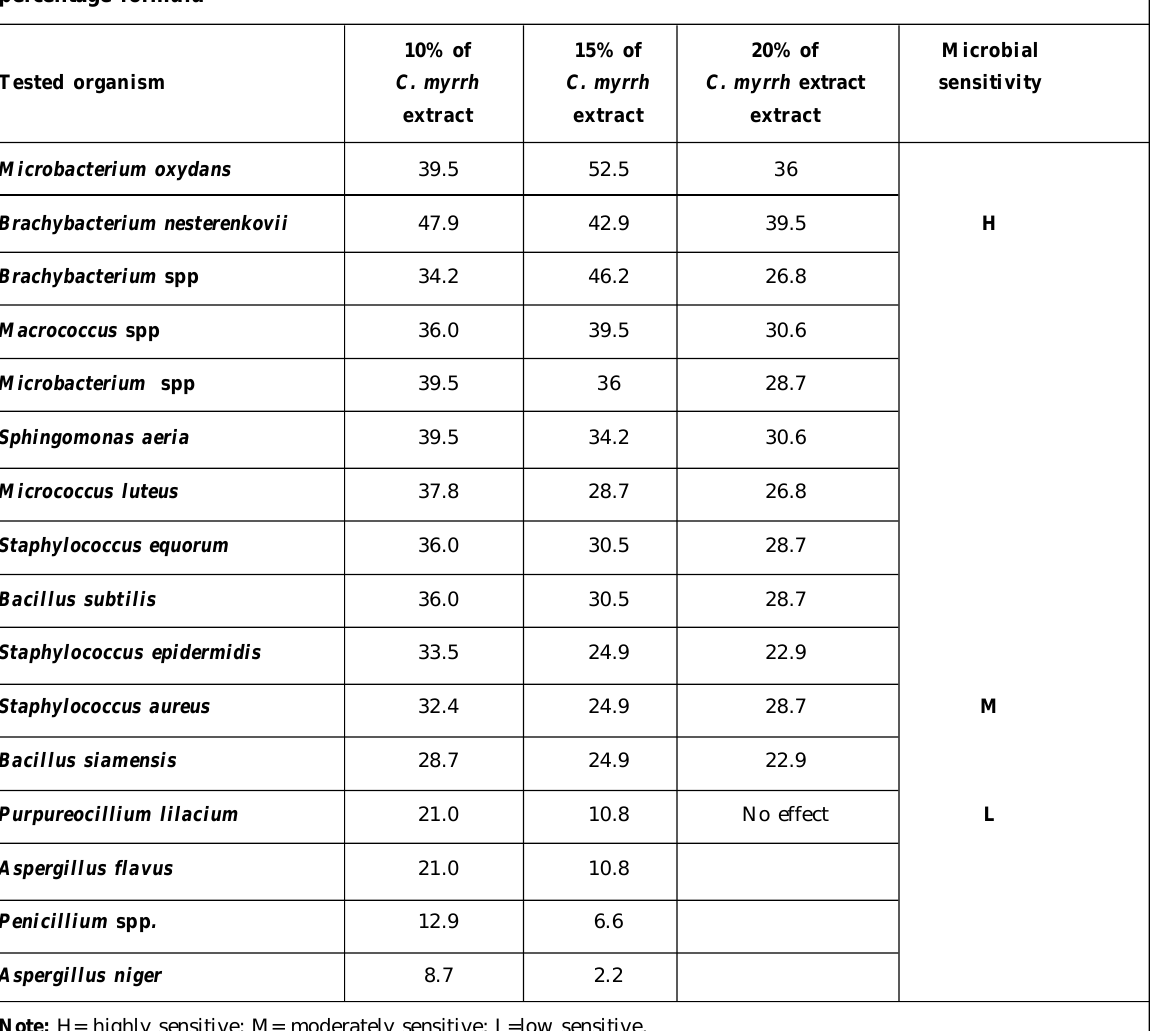
Table 2: Effect of C. myrrh different concentrations on the growth of tested organisms using inhibition percentage formula 10% of 20% of Microbial Tested organism